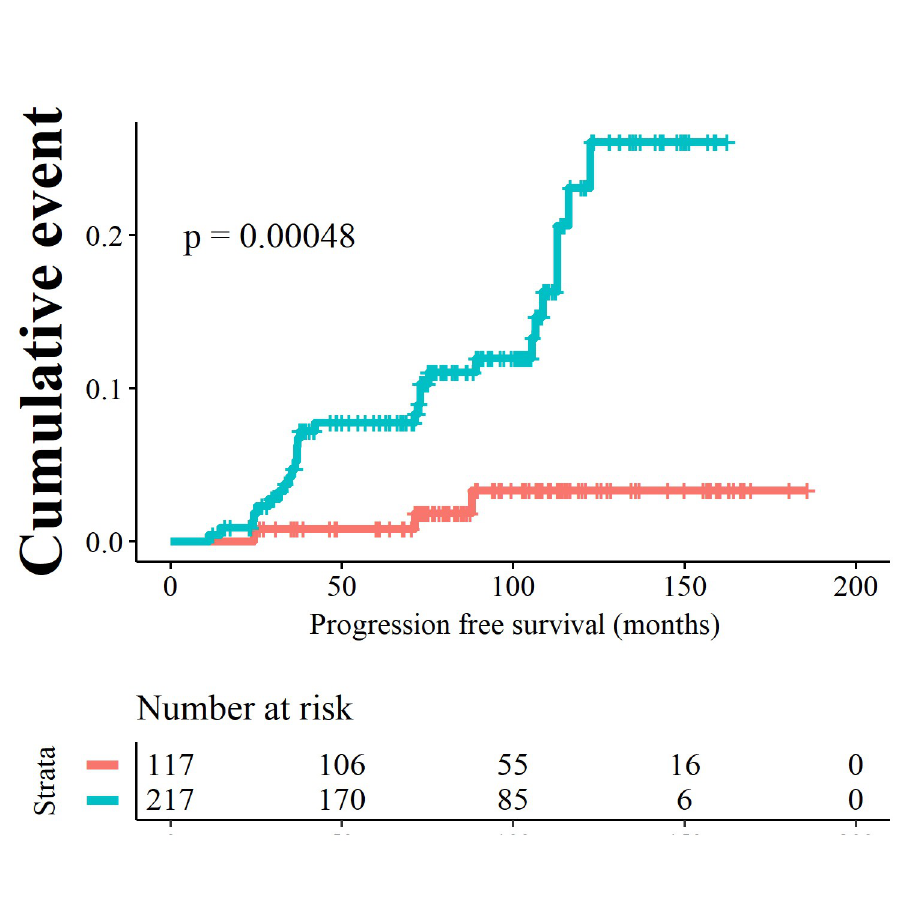
Fig 7. Kaplan Meier curve showing progression to HGD/EAC resulting from binary cut offs of the risk score at 3.93. Patients with a low risk score are depicted by the orange curves, patients with high risk scores are depicted by the blue